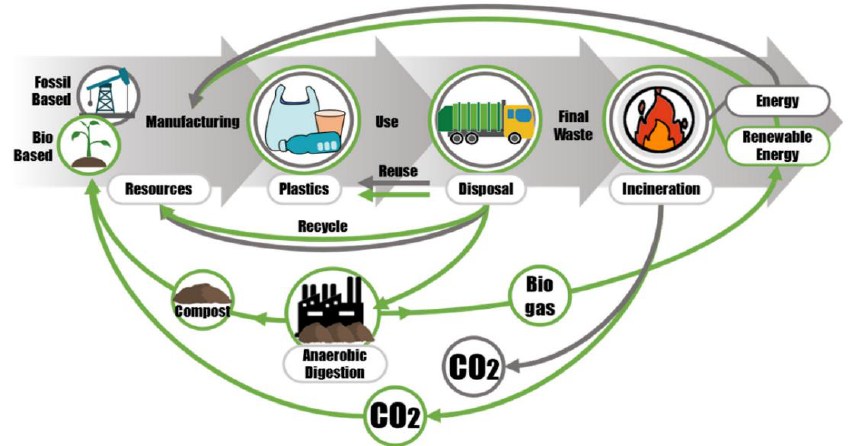
Figure 1. An infographic representation of the linear and circular economy of bioplastics. Reproduced from ref [22].